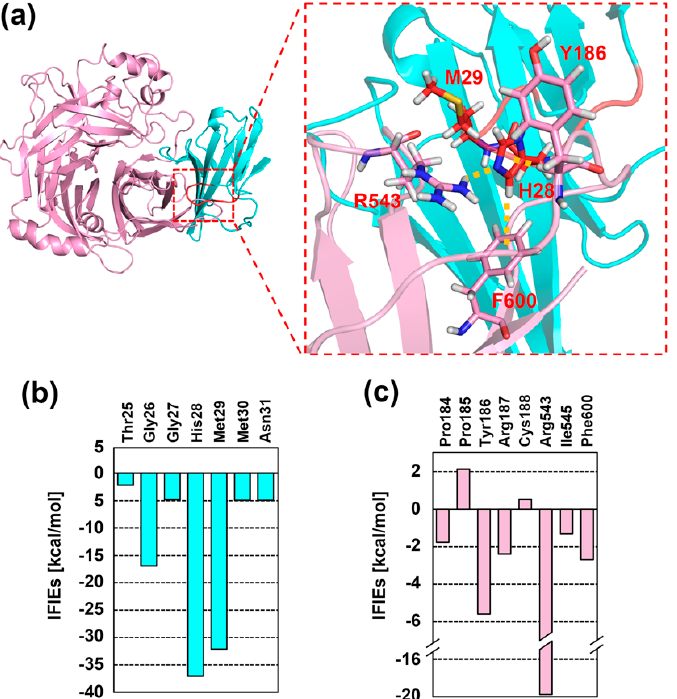
Figure 2. ( a ) Residues at the interaction interface between CDV-H (pink) and macaca SLAM (cyan). ( b,c ) inter-fragment interaction energies (IFIEs) of the interacting residues of macaca SLAM (cyan bar, ( b ) and CDV-H (pink bar, ( c ) by fragment molecular orbit (FMO) analysis.